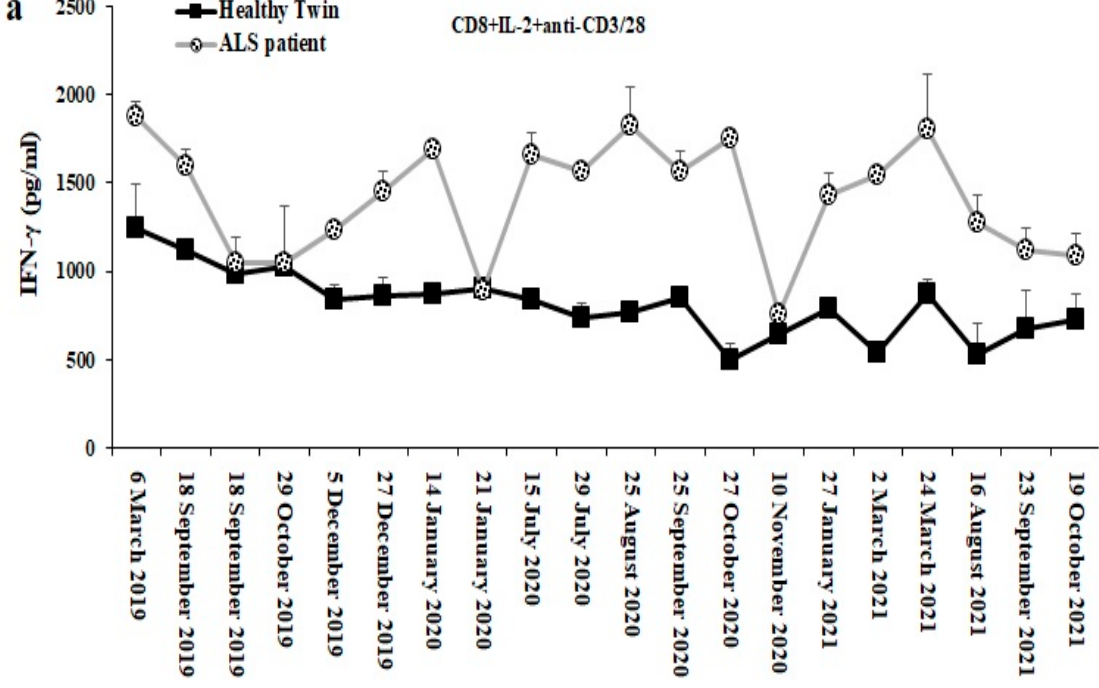
Figure 10. Levels of IFN- γ secretion by CD8+ T cells from ALS patients in comparison to healthy individuals in chronological order. CD8+ T cells of healthy individuals and those from ALS patients were isolated from PBMCs as described in Section 2. CD8+T cells (1 × 10 6 cells/mL) were treated with a combination of IL-2 (100 U/mL) and anti-CD3/28 antibody (25 µL/mL) for 18 h before the supernatants were harvested to determine IFN- γ secretion using single ELISA (a). The data was obtained at different time points as shown in the figures. Duplicate samples from healthy individual and ALS patient were used at each time point.